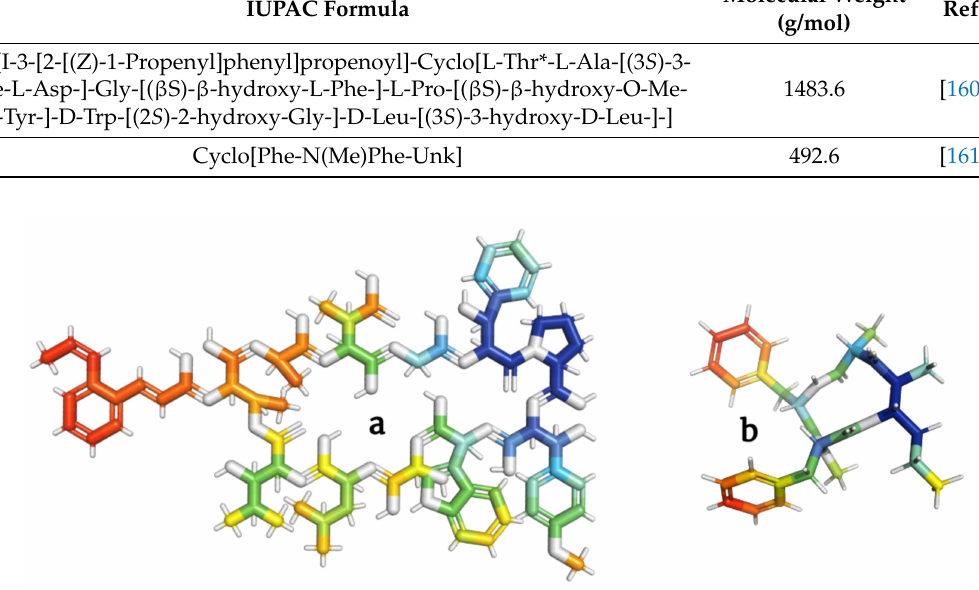
Figure 7. Models of skyllamycins ( a ) and stereocalpin ( b ) depsipeptides inhibiting the growth of tumor